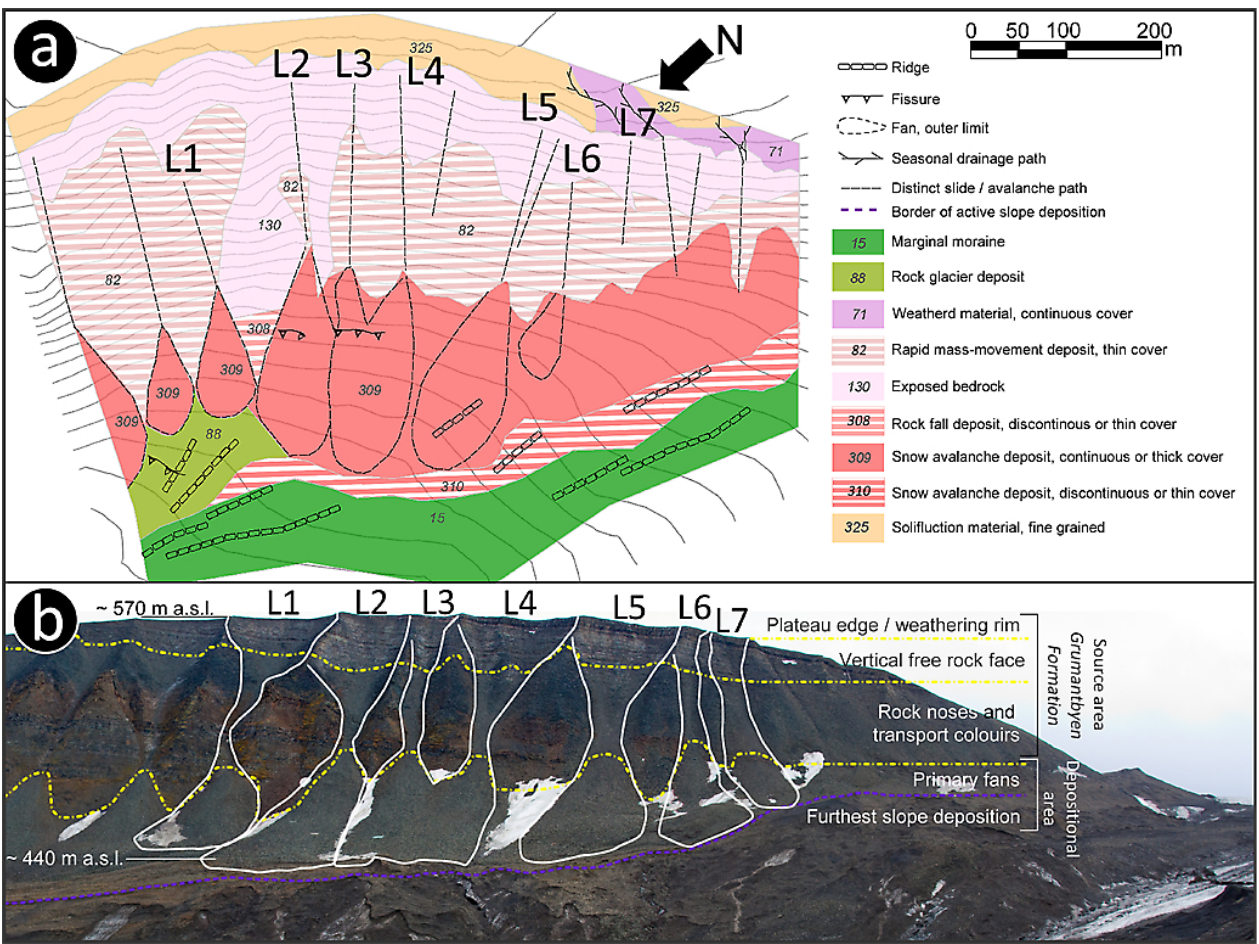
Fig. 4. (a) Geomorphology and sediments of the Larsbreen slope system based on detailed geomorphological field mapping and 3-D aerial photogrammetry. (a) Larsbreen with the seven catchments (L1–L7) (white line). The white lines indicate the maximum runout distance of cornice fall avalanches observed. The yellow dashed lines indicate different parts of the source and depositional areas or delimit the geological formations. The purple line indicates the maximum extent of the slope